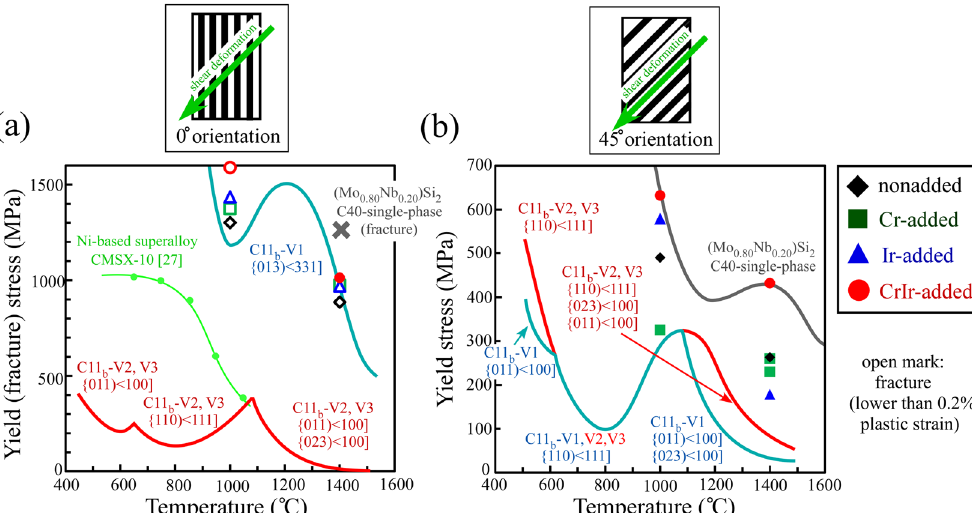
Figure 2. Variations in the yield (fracture) stress of the lamellar crystals. The yield (fracture) stresses were measured by compression tests at 1000 and 1400 °C in the ( a ) 0° and ( b ) 45° orientations. In the figures, the expected temperature dependencies of the yield stresses for the three C11 b variant grains and C40-matrix phase in the lamellar-structured crystals, according to the evaluation in the previous papers 5, 15, 24 , are also drawn for comparison. Open marks indicate that the specimen was fractured before reaching 0.2% plastic